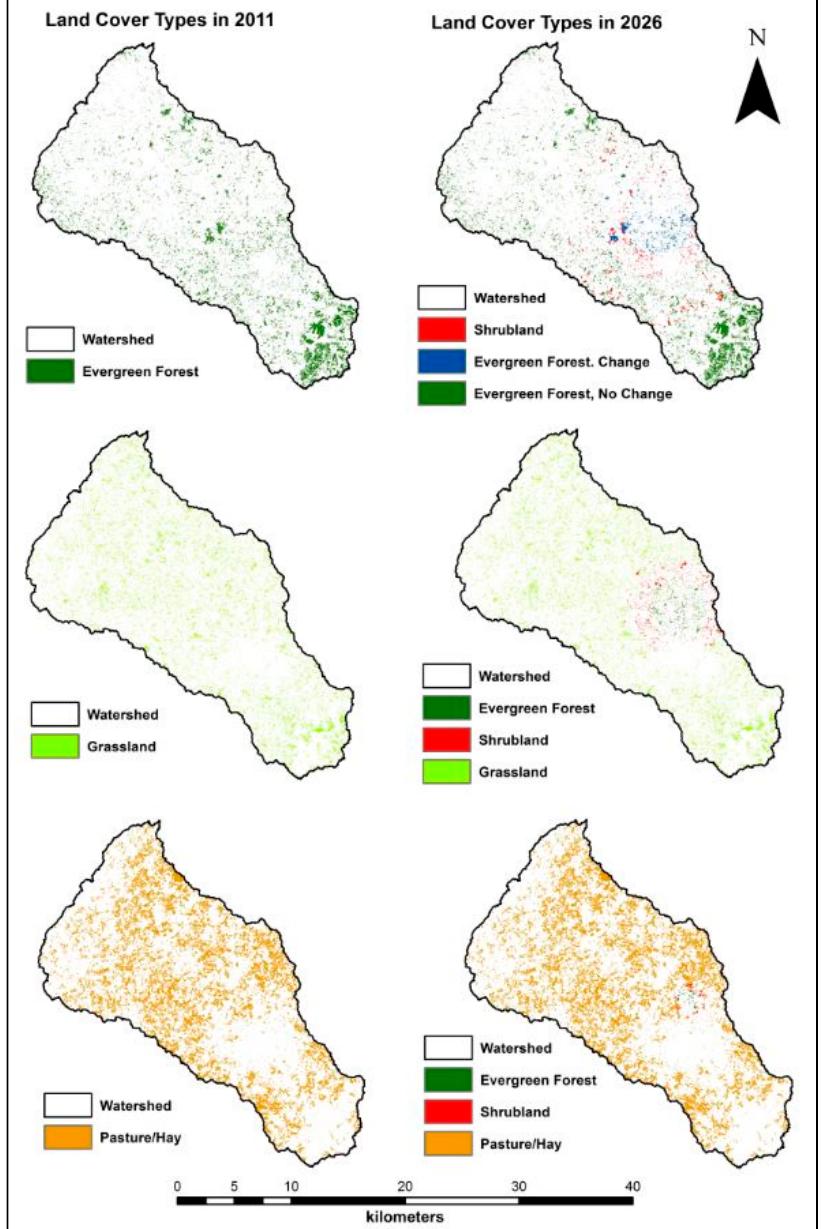
Figure 7. Transition of pixels to evergreen forest and shrubland over space and time under the Low Demand scenario.